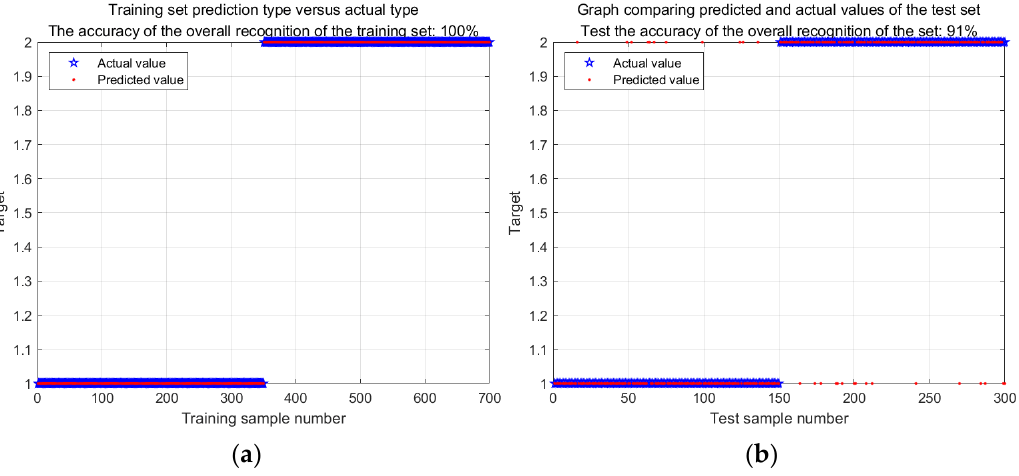
Figure 10. Single operation result of EEMD-MPA-KELM model. ( a ) model training sets predict results; ( b ) model test sets predict results.